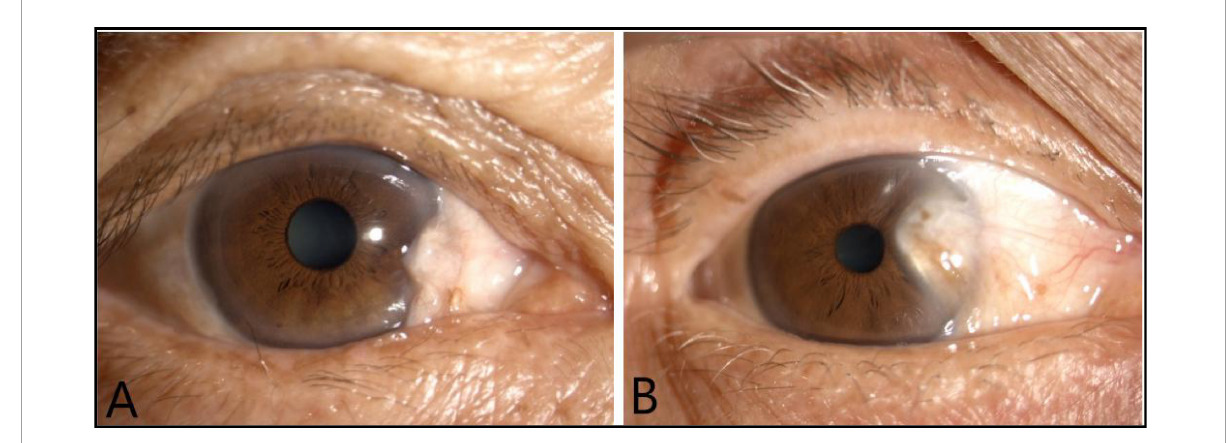
FIGURE1 The anterior segment images of two group: The anterior segment image of the non-surgery group (A) . The anterior segment image of the surgery group (B) .